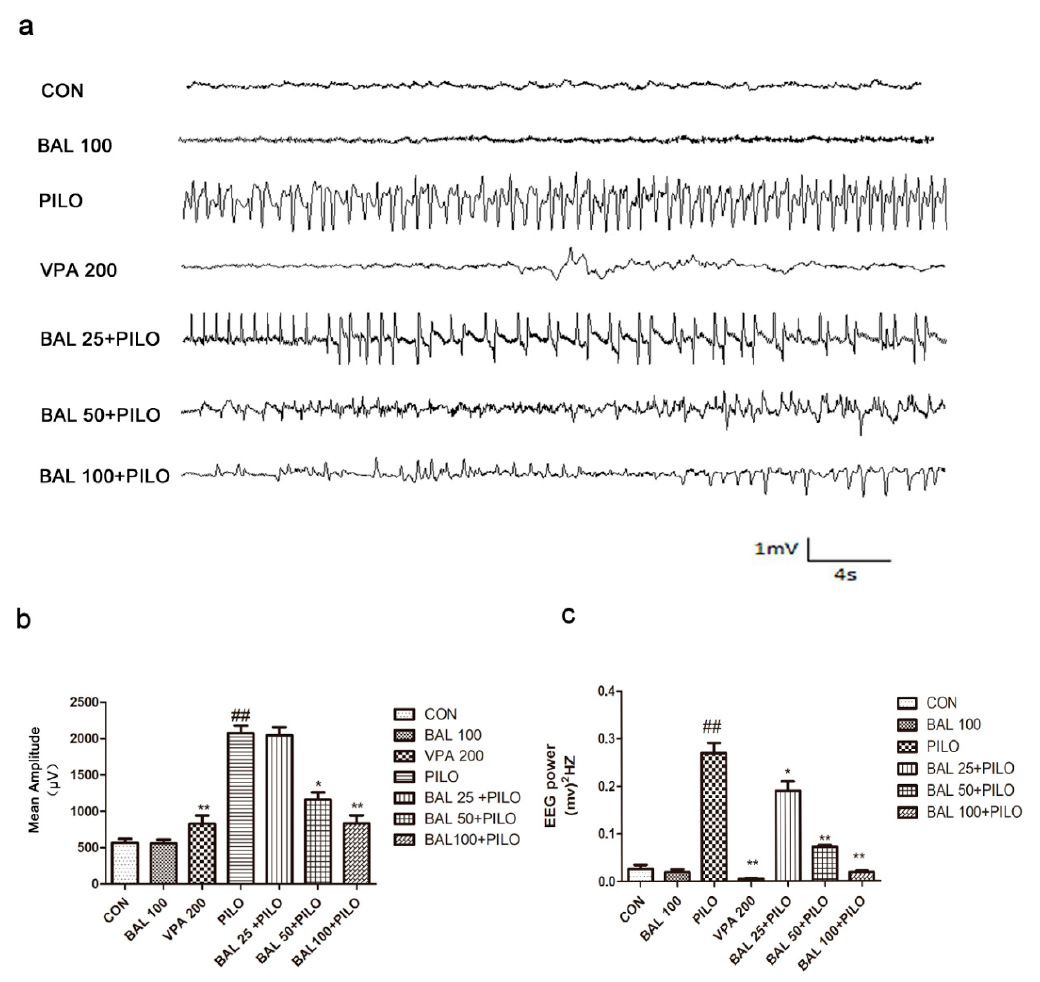
Figure 2. Electroencephalogram (EEG) recordings after PILO treatment. Representative EEG recordings 25 min post PILO injection ( a ). The mean amplitude of seizure EEG ( b ). The total EEG power of seizure ( c ). Results are expressed as mean ± SEM ( n = 12). ## p < 0.01 (Student-Newman-Keuls) compared to the CON group, * p < 0.05 (Student-Newman-Keuls) compared to the PILO group, and ** p < 0.01 (Student-Newman-Keuls) compared to the PILO group (One-way ANOVA and the Student-